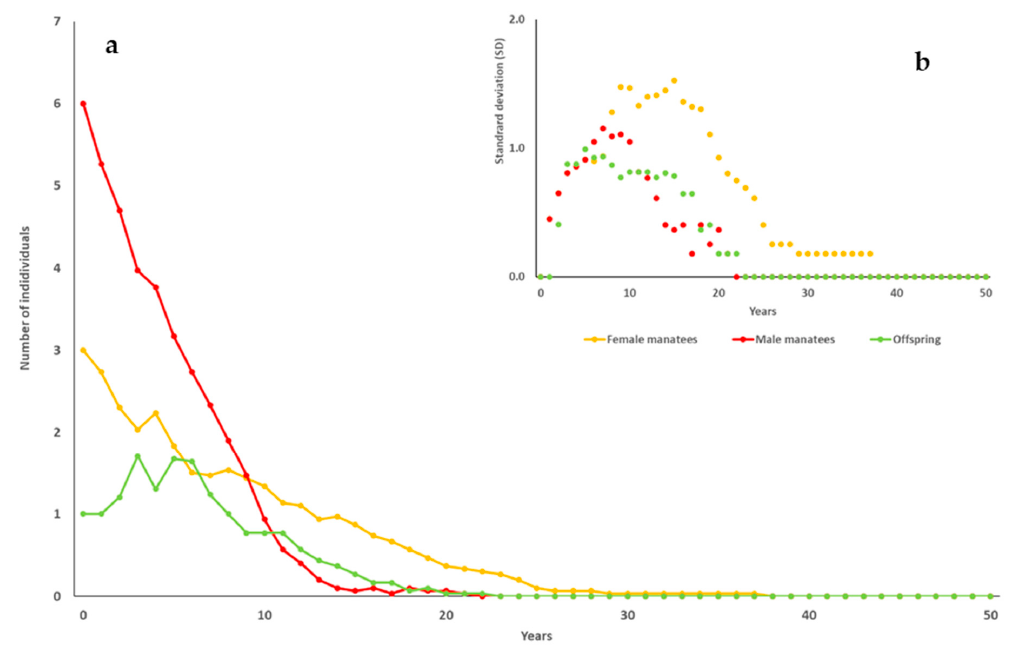
Figure 5. ( a ) The mean number of individuals per year for n = 30 runs; ( b ) the standard deviation of the mean number individuals per year for all the runs ( n = 30).